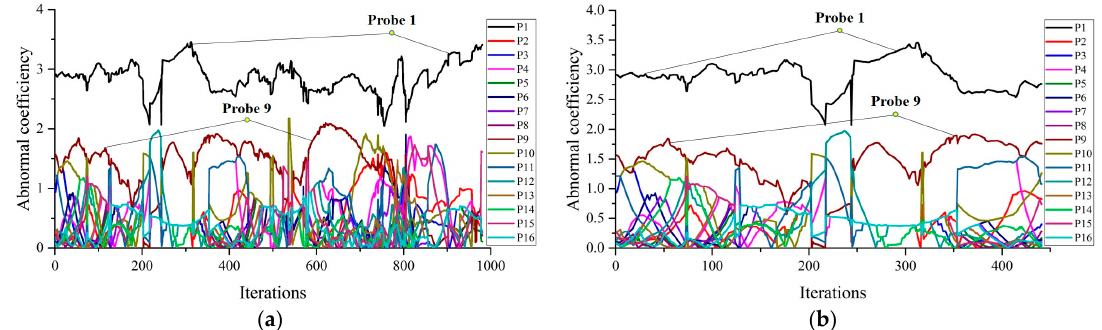
Figure 6. The abnormal coefficient in the ( a ) first 6 h and ( b ) first 3 h of Vehicle 1.